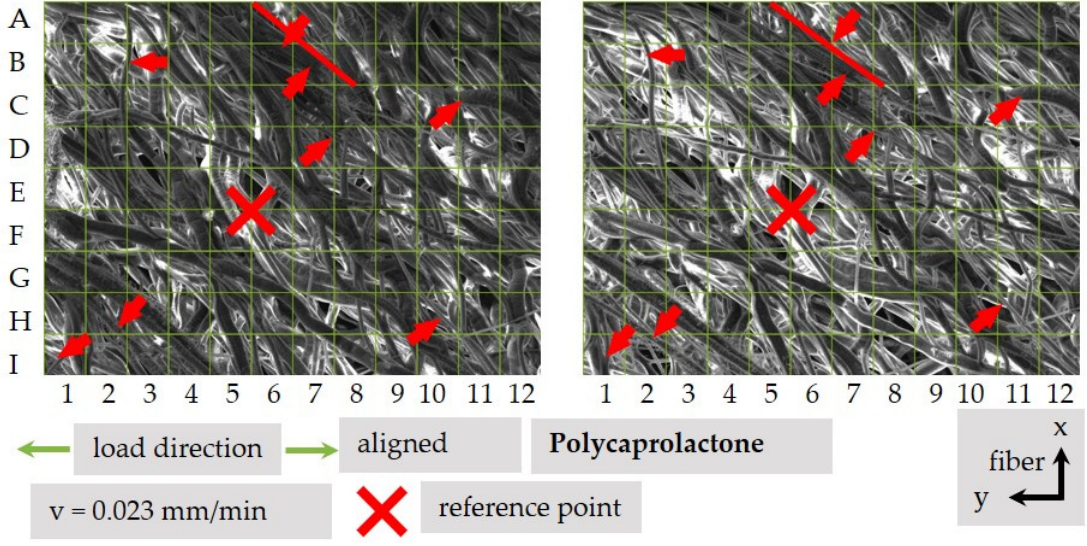
Figure 12. Fiber movement of a 90° sample.